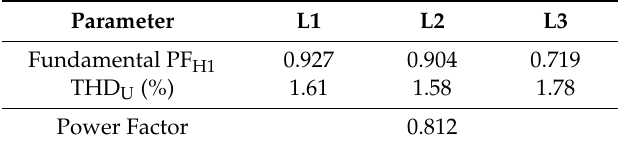
Table 5. Fundamental power factor (PF H1 ), THD U for individual phases and power factor.